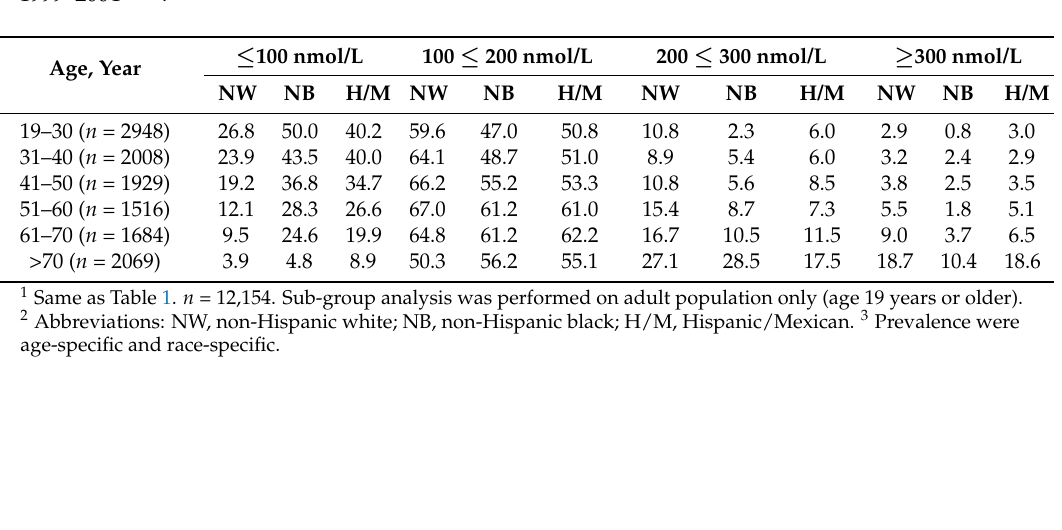
Table 3. Prevalence (%) of serum methylmalonic acid (MMA) concentrations in non-Hispanic white, non-Hispanic black and Hispanic/Mexican by age: National Health and Nutrition Examination